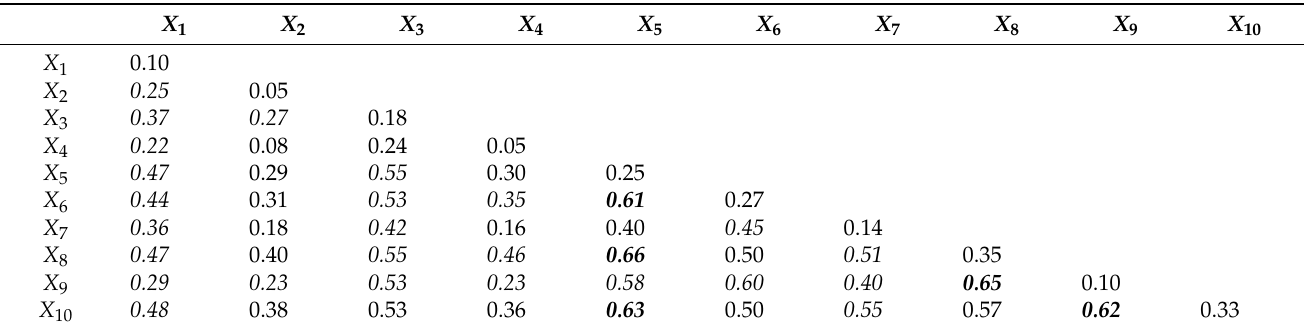
Table 6. Interaction detector of village economy digitalization